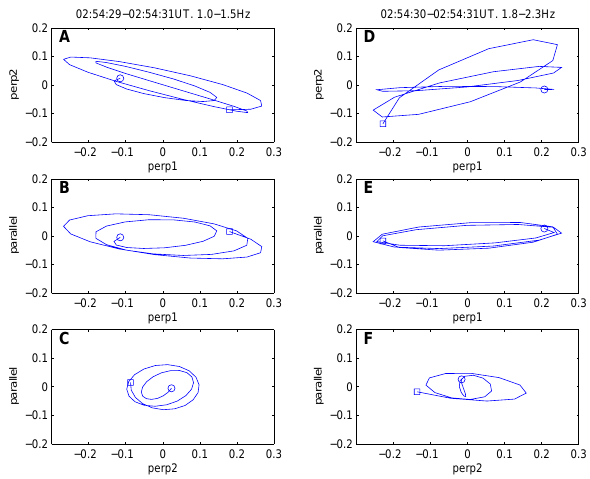
Fig. 4. Hodograms of the wave magnetic field from C4 in a field- aligned coordinate system, filtered in two different frequency inter- vals below and above f cp , respectively. The square marks the start of the time series, and the circle the